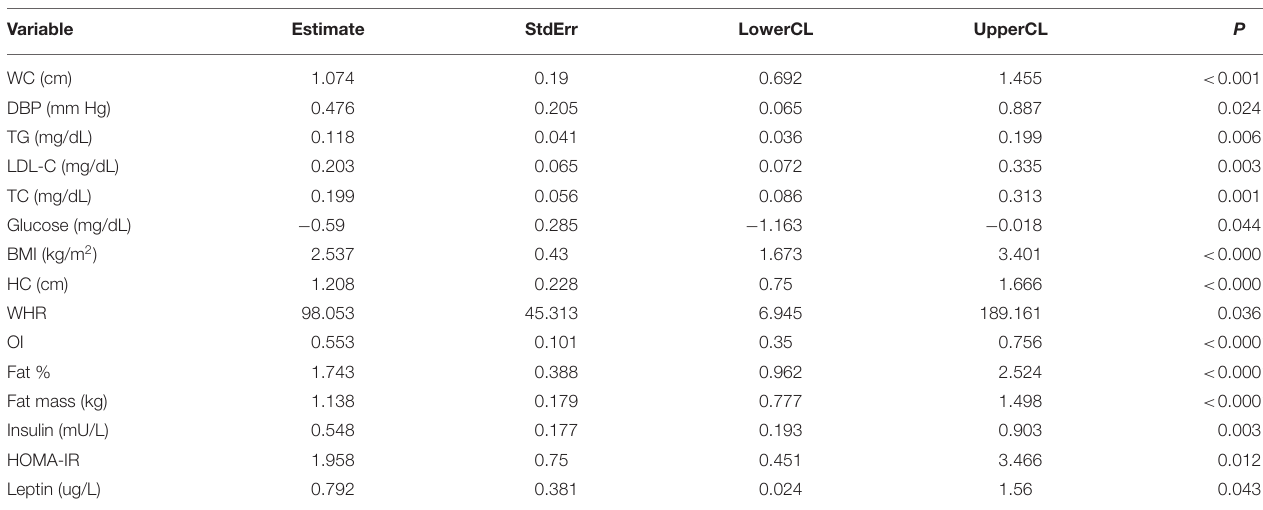
TABLE 9 | Correlations between visceral fat tissue and other metabolic